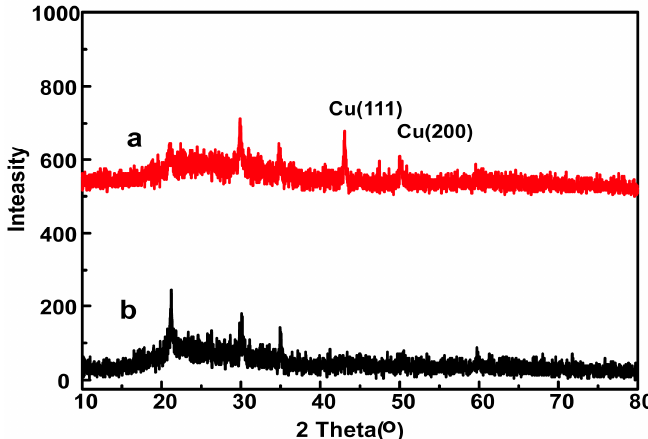
Figure 2. XRD patterns of (a) CuO/PCL@PPy/ITO and (b) PCL@PPy/ITO electrodes.